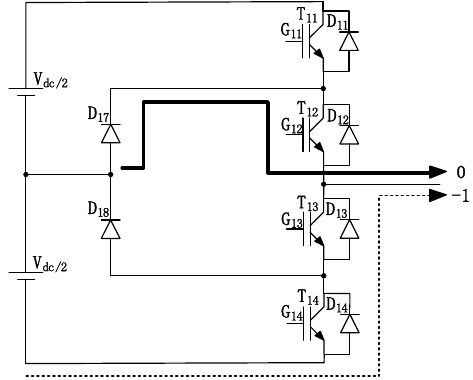
Figure 6. D4 type ( α = − 1, M ≈ 0).